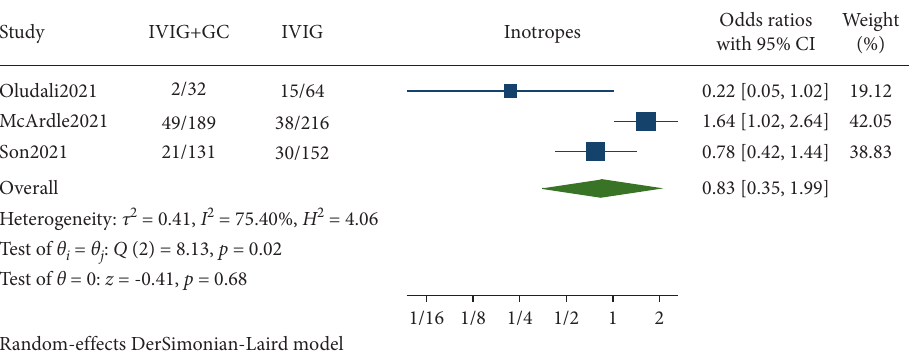
Figure 5: Forest plot showing the comparison of need of inotropic support in IVIG plus glucocorticoids versus Table 2: Quality assessment of included cohort studies.